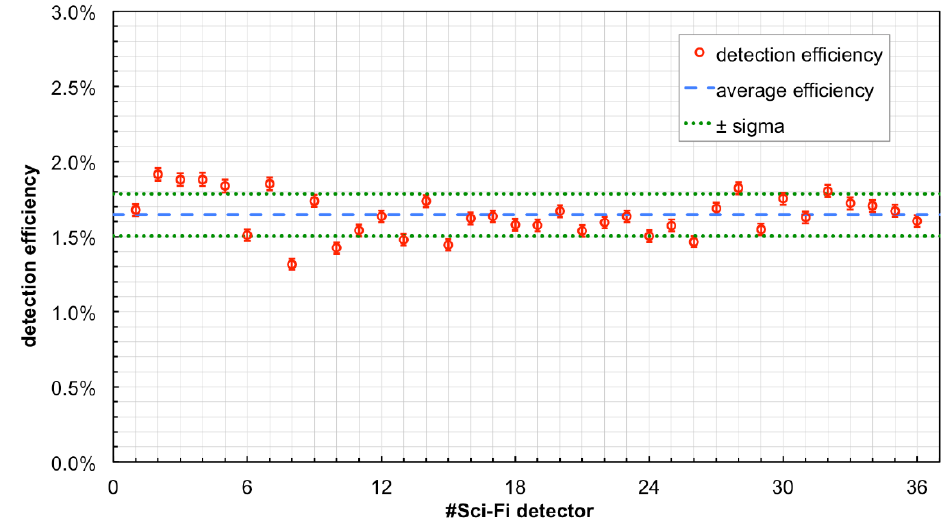
Figure 15. Measured detection efficiency with 662 keV gamma-rays from the 137 Cs source. The error bars represent the statistical uncertainty; the blue dashed line is the average efficiency; the green dotted lines indicate ±1 standard deviations from the average.